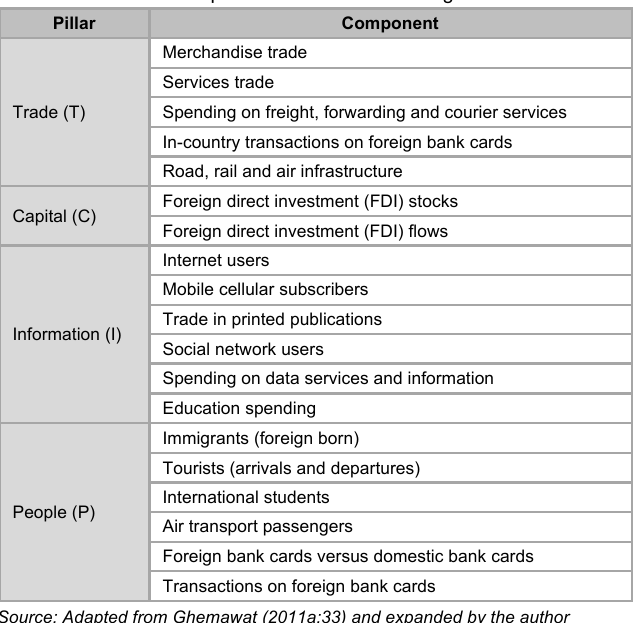
Pillars and components of Visa Africa integration index Pillar